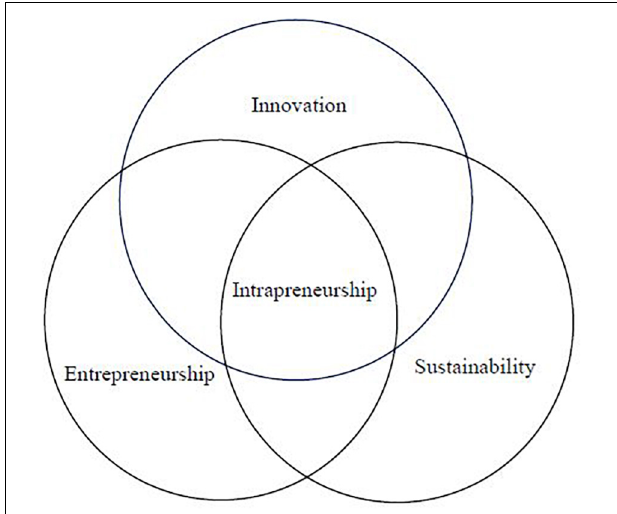
FIGURE 2 | Venn diagram showing the concept of intrapreneurship shared by innovation, entrepreneurship, and